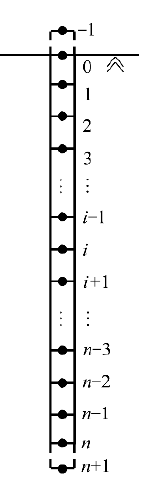
Figure 5. Schematic of discretization of a pile for numerical difference analysis.